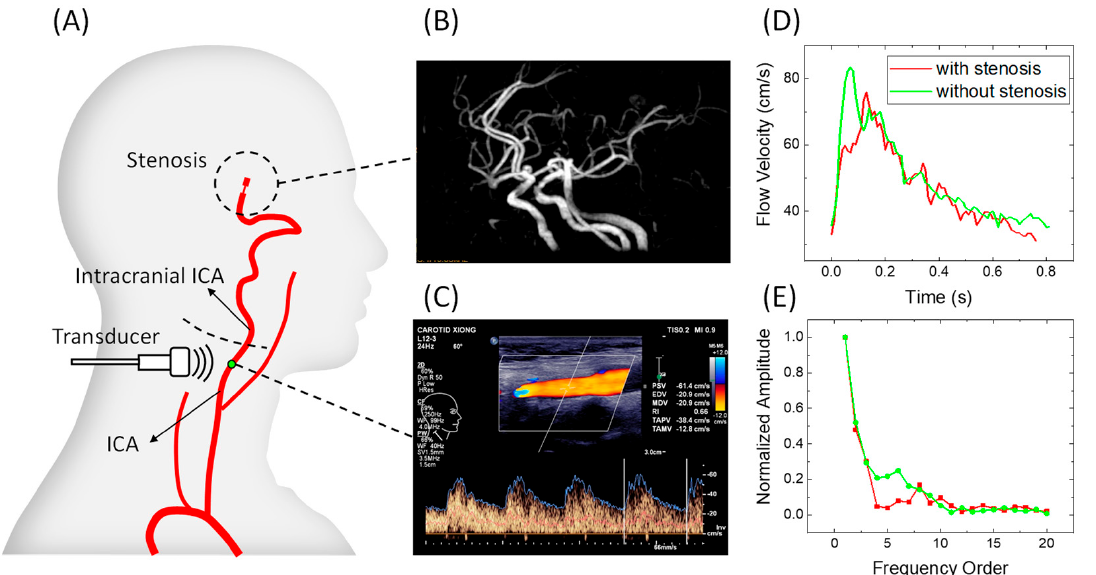
Figure 2. Schematic images of the measurement procedure: ( A ) schematic diagram of a stenosis location and the Doppler ultrasound measurement location; ( B ) magnetic resonance angiography image of a patient with IICAS; ( C ) original image of ICA flow waveforms and measurements of the PSV, EDV, and RI; ( D ) typical digitalized single-period flow velocity waveforms of a patient with IICAS and a patient without IICAS; ( E ) normalized harmonic amplitudes of waveforms in ( D ). ICA, internal carotid artery; IICAS, intracranial internal carotid artery stenosis; PSV, peak systolic velocity; EDV, end-diastolic velocity; RI, resistive index.